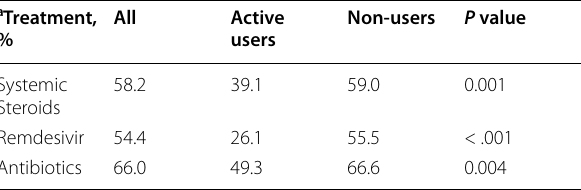
a Fisher’s exact test